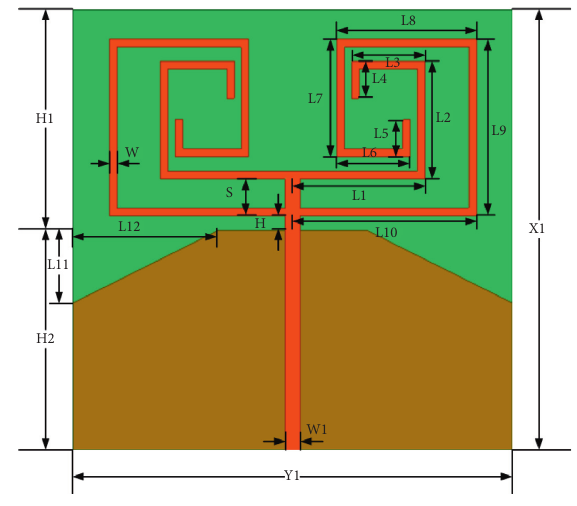
Figure 2: Antenna model size drawing. Table 1: Antenna